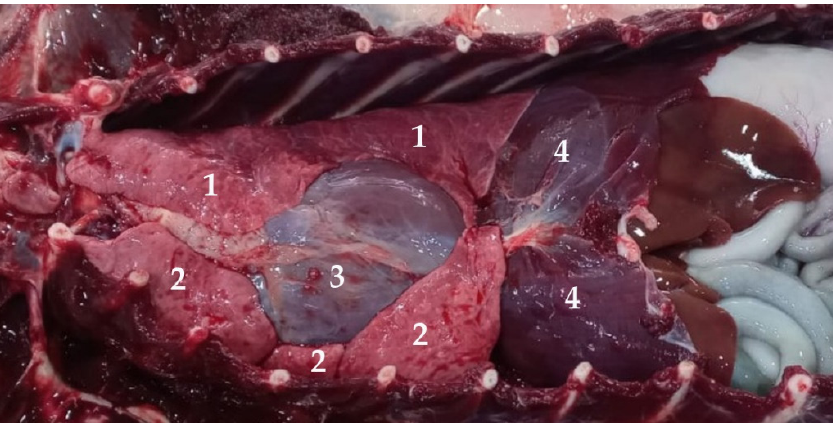
Figure 11. Ventral view of the thoracic cavity of Arctocephalus australis : (1) left lung; (2) right lung; (3) heart; (4) diaphragm.